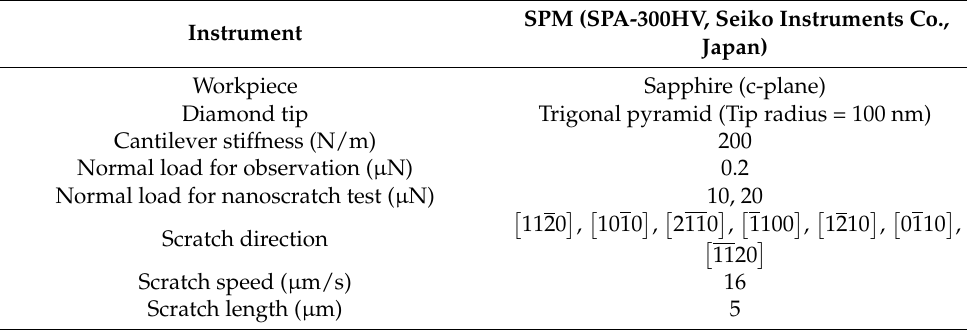
Table 3. Experimental conditions for the single groove nanoscratch test.